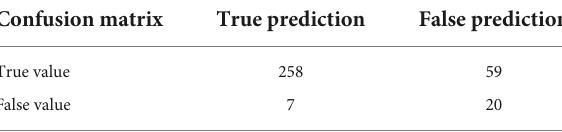
TABLE 4 Confusion matrix for the in-house training dataset.